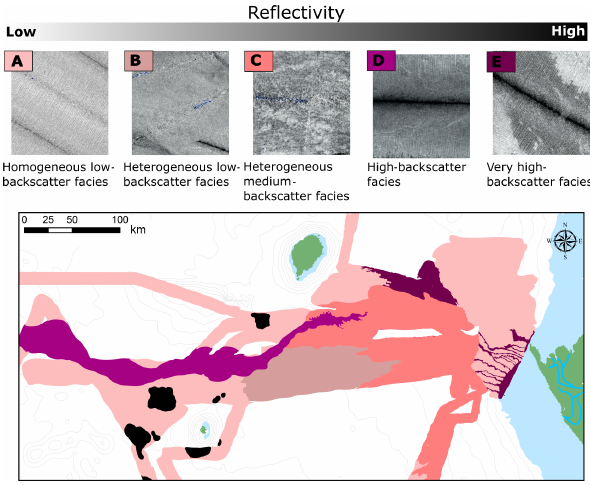
Figure 4. Reflectivity facies map of the Ogooue Fan showing the five main backscatter